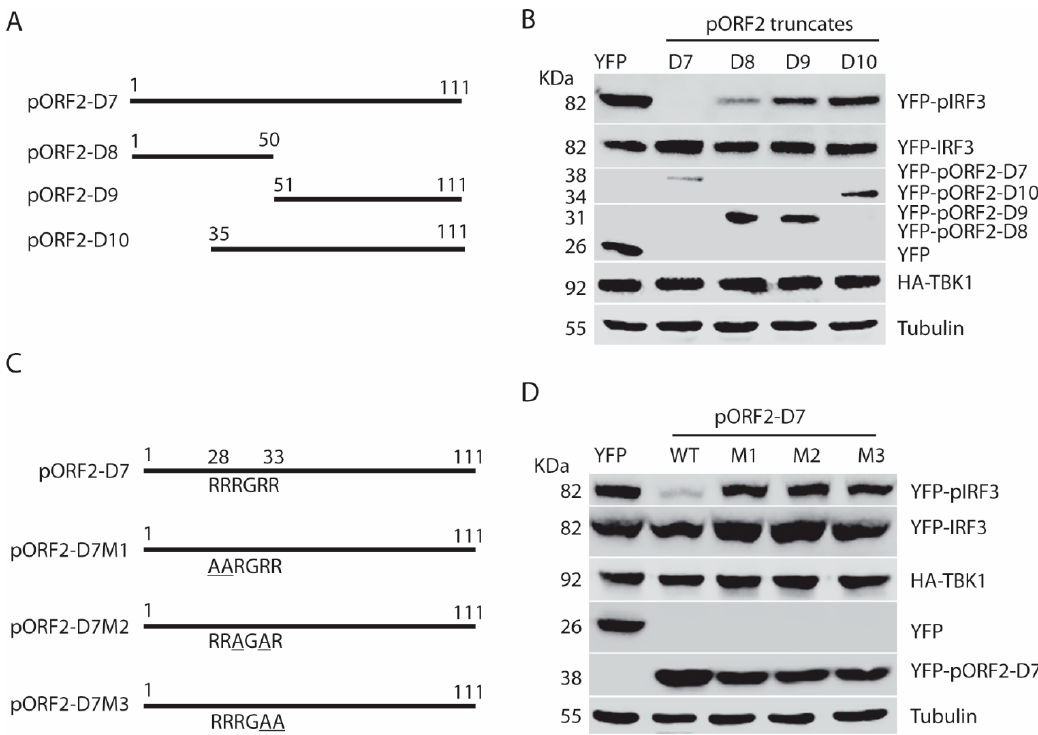
Figure 7. Arginine-rich motif aa28-33 (RRRGRR) in the first 111 aa of the capsid protein is indispensable for inhibition of IRF3 phosphorylation. ( A ) Schematic illustration of truncation mutants of the first 111 aa of the capsid protein. ( B ) Domain screening of ORF2 truncations in the inhibition of TBK1-mediated IFN induction. The HEK293-IRF3 stable cell line was co-transfected with ORF2 N-terminal truncations and TBK1 plasmids for 36 h, and the samples were harvested for WB. ( C ) Schematic illustration of mutants of arginine-rich motif aa28-33 in the capsid protein. ( D ) All three mutants lose the inhibition of IRF3 activation. The HEK293-IRF3 stable cell line was transfected with three mutant plasmids and TBK1. The pIRF3 level was detected at 36 hpt by WB.